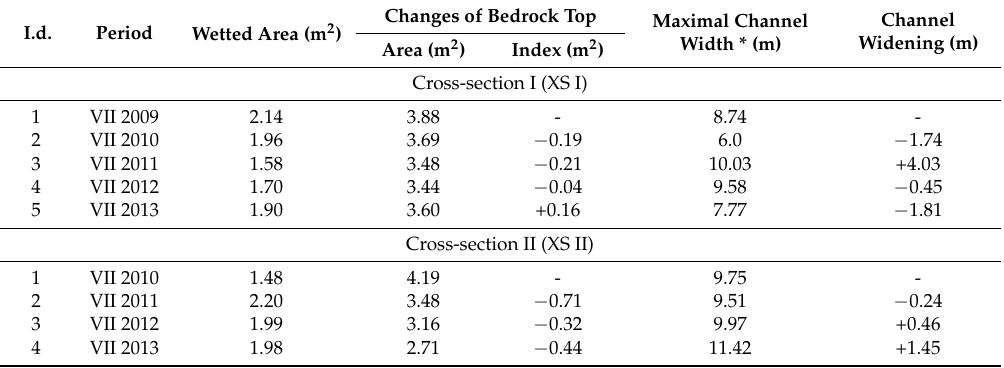
Table 4. Comparison of selected scour indices for the Scott River channel